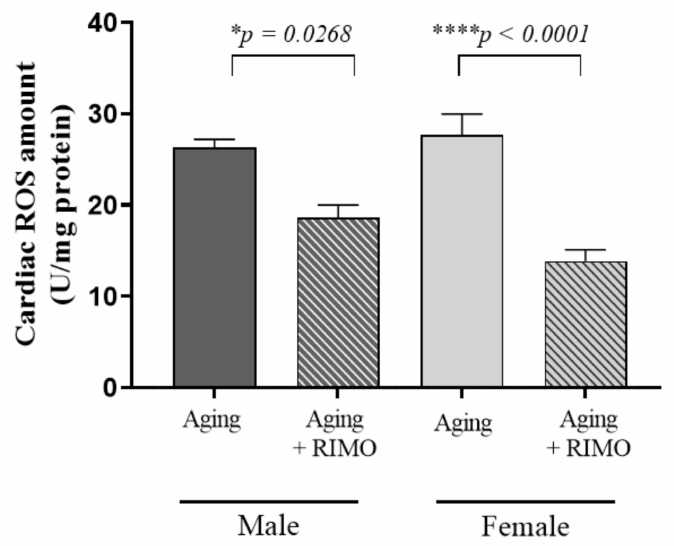
Figure 1. The effects of rimonabant treatment on cardiac ROS concentration in aged animals. (ROS; ex-pressed as unit/mg) Results are shown as means S.E.M. n = 5–6. * p < 0.05, **** p < 0.0001: Statistical significance between rimonabant-treated and untreated, sex-matched aging rats, RIMO = rimonabant, ROS = reactive oxygen